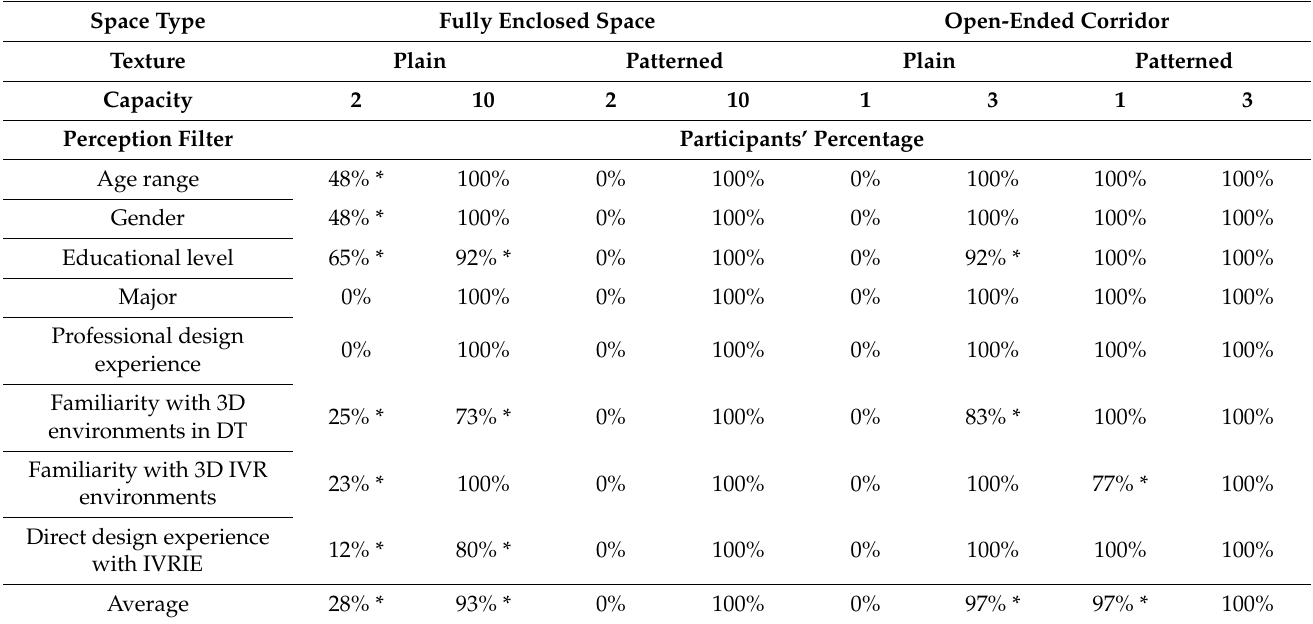
Table 11. Perception filters and participants’ percentage with significantly different design results between the two